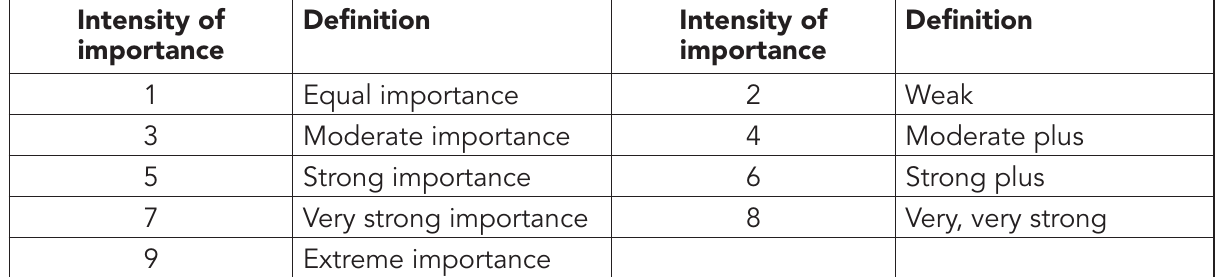
Table III: Scale for relative